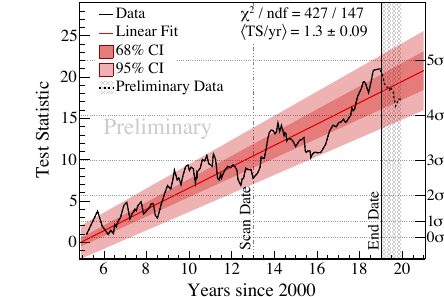
Figure 8: The time evolution of the TS with significance indicated on the right. The shaded region is preliminary data.